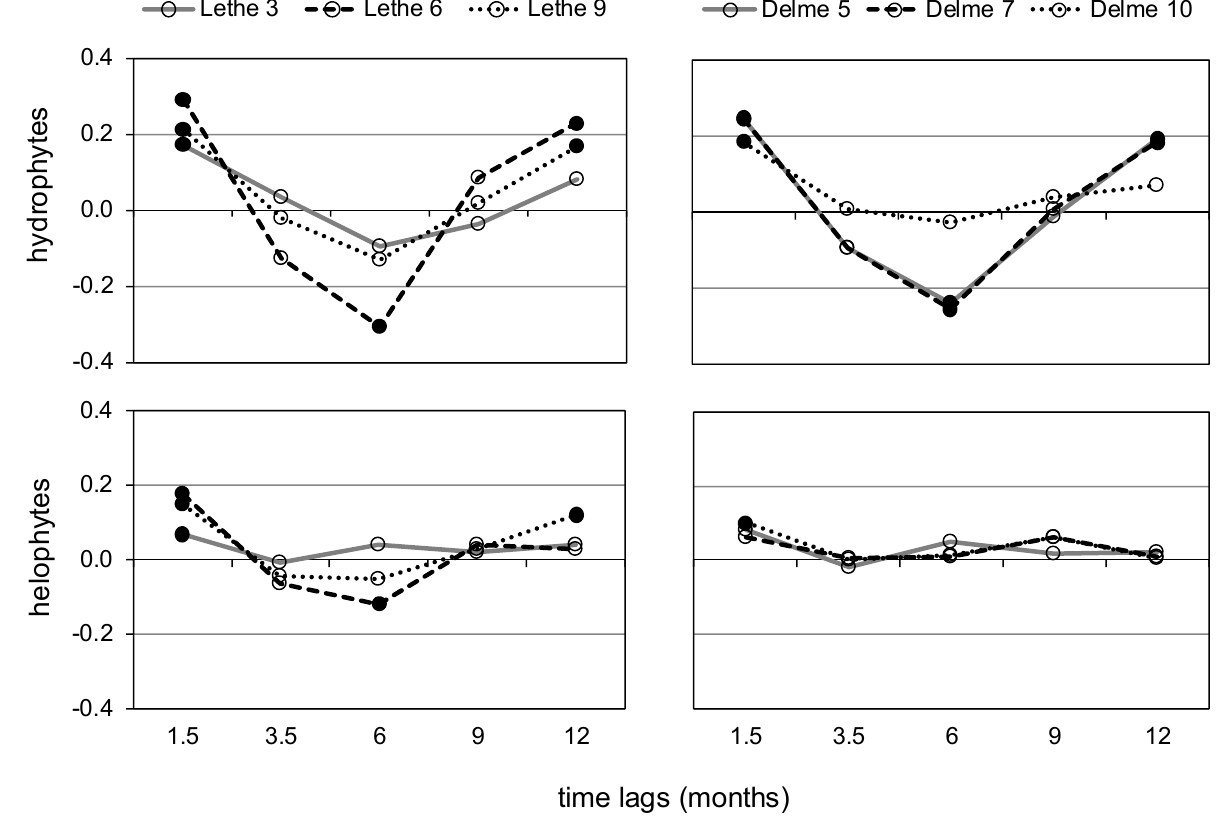
Figure 4. Temporal autocorrelograms of plant species composition at monthly time steps. Significant tests are indicated by a filled symbol (after Bonferroni correction of α = 0.05/k). Mantel statistics range from − 1 to 1. Positive Mantel statistics represent positive autocorrelation. Number of comparisons per class ranged from 39 to